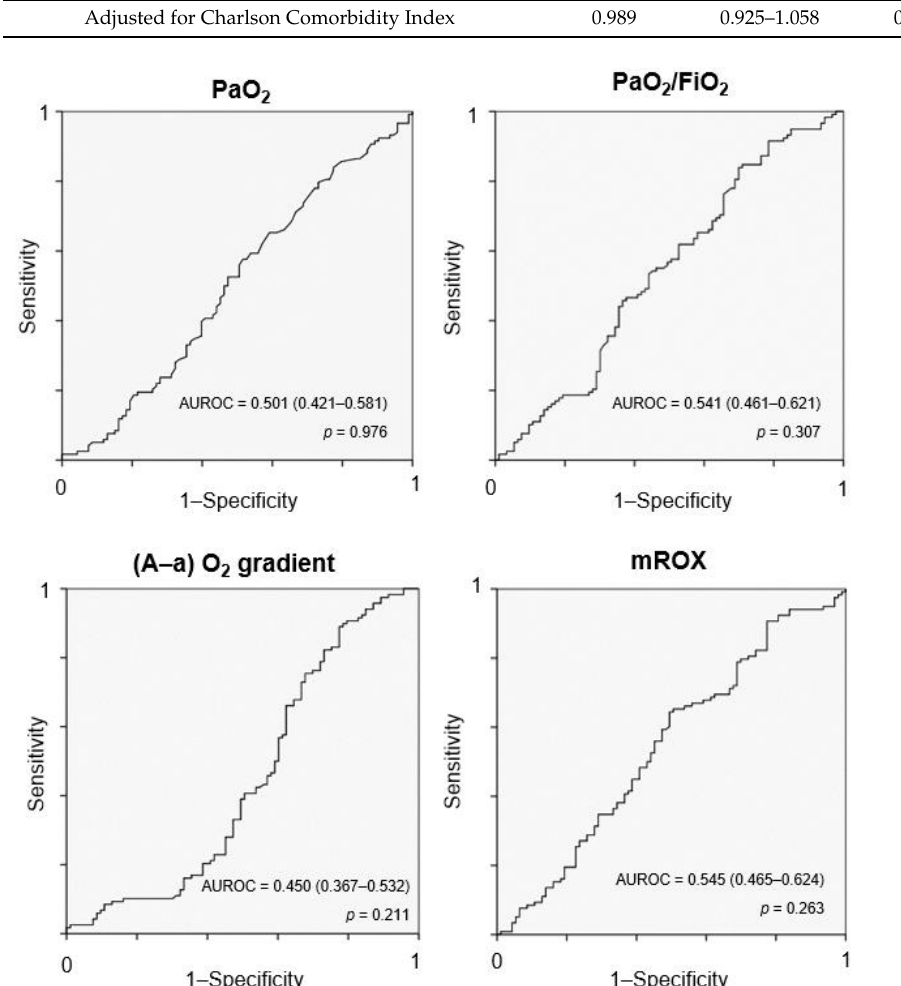
Figure 2. ROC curves for absolute increases in PaO 2 , (A-a) O 2 gradient, PaO 2 /FiO 2 ratio, and mROX before and during CPAP, and relative differences. PaO 2 = arterial partial pressure of oxygen; FiO 2 = fraction of inspired oxygen; (A-a) O 2 gradient = alveolar-arterial oxygen gradient; mROX = PaO 2 /FiO 2 /respiratory rate; AUROC = area under the ROC curve.